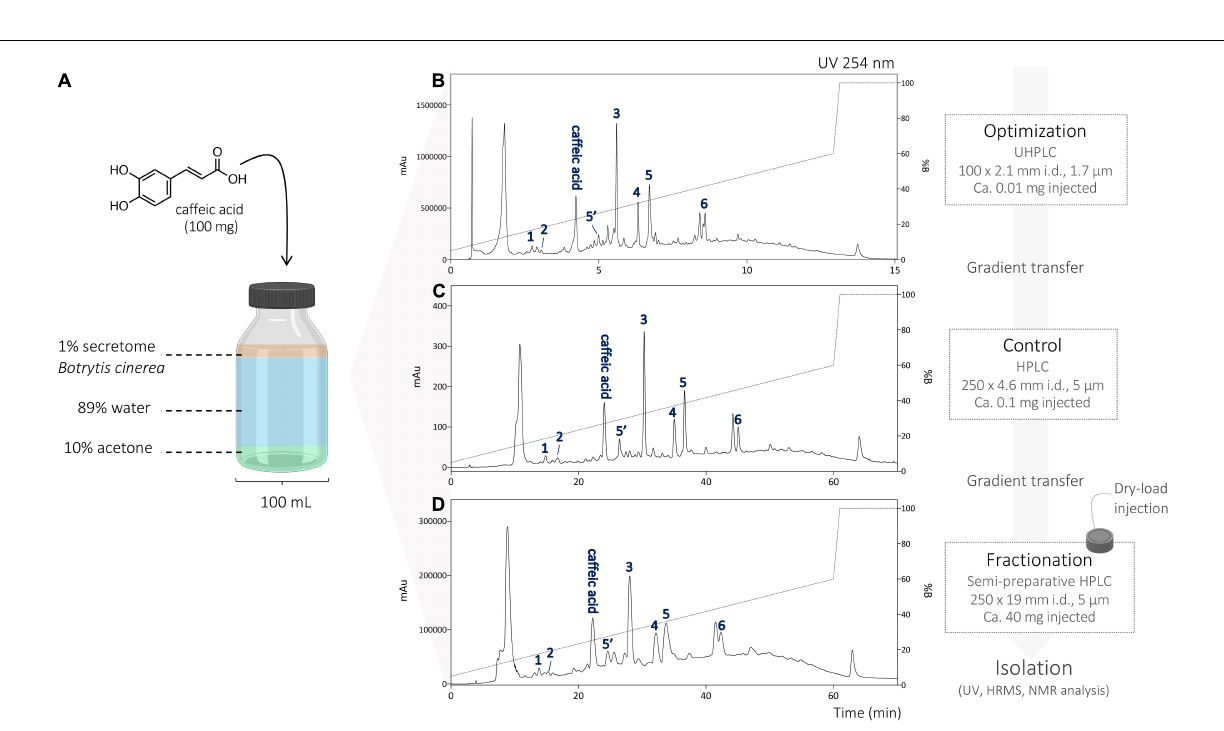
Frontiers in Plant Science |